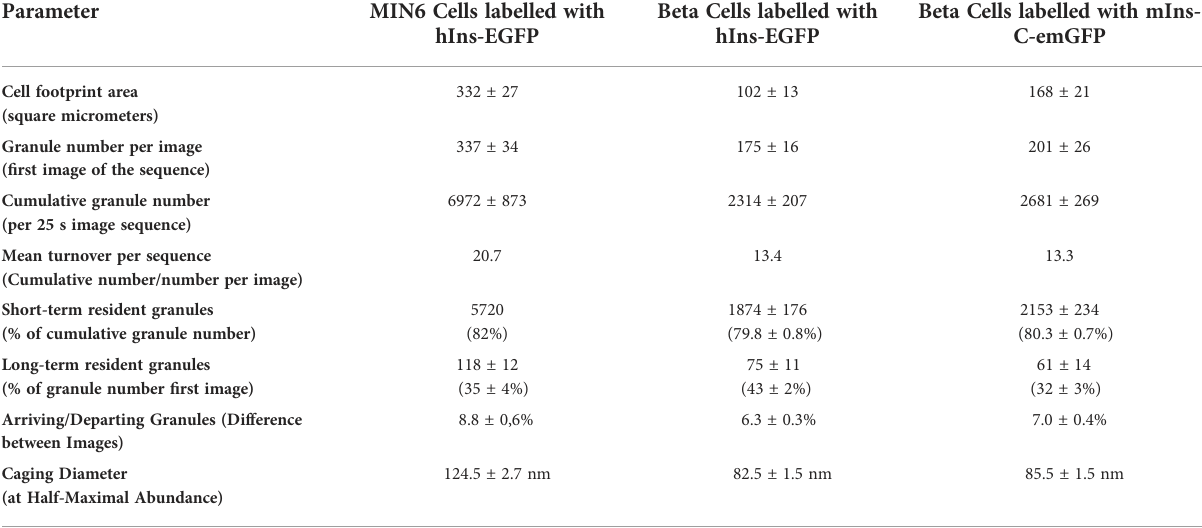
Values are taken from 42 and from